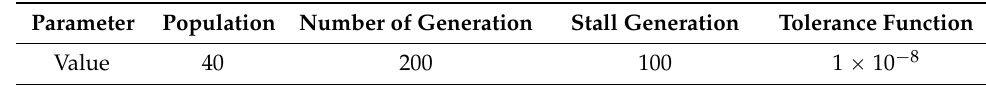
Table A1. Parameters of genetic algorithm (GA).